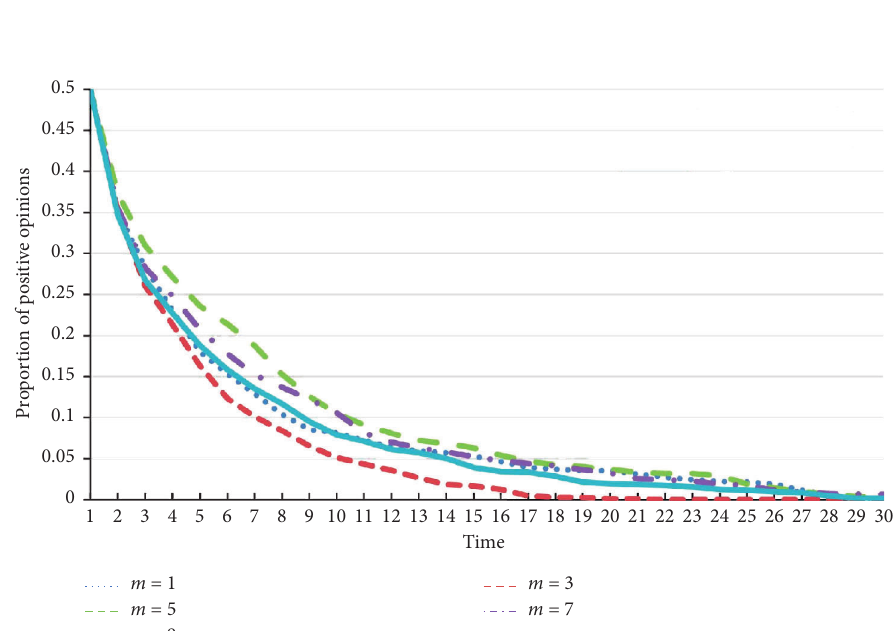
Figure 1: The opinion evolution trends for the initial proportion pp � 0 . 5 in scale-free networks with m